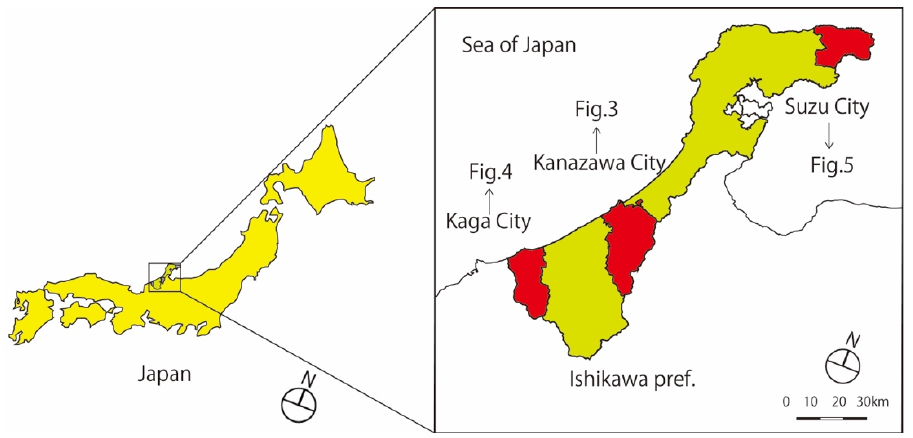
Figure 1. Target cities for this study.